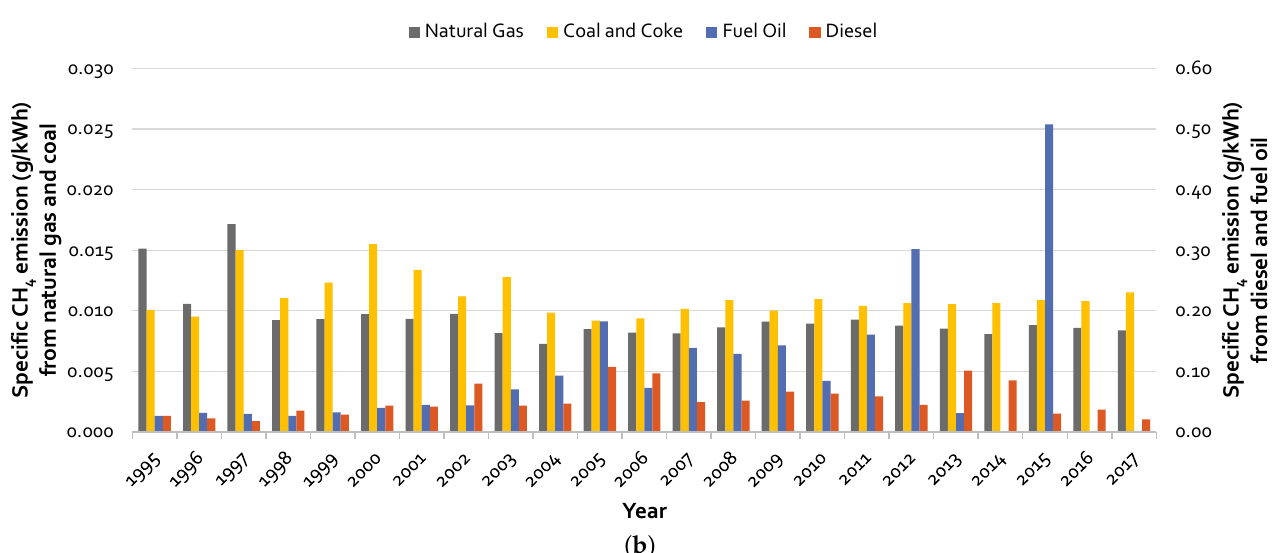
Figure 12. ( a ) Total annual and ( b ) specific CH 4 emissions from Malaysia electricity generation sector from 1995 to